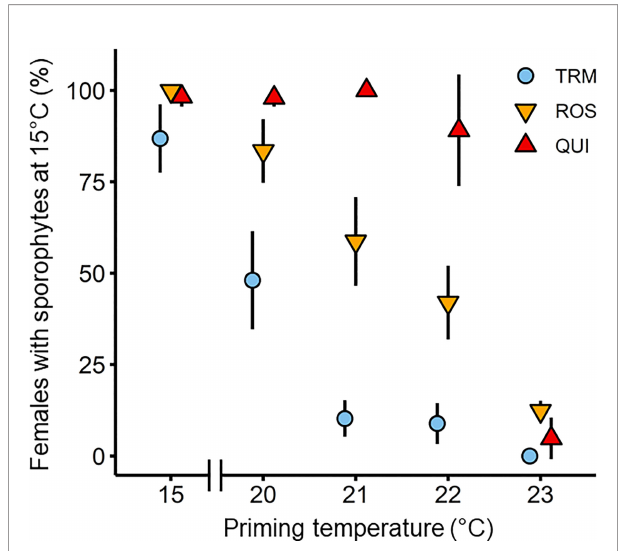
FIGURE 4 | Formation of microscopic sporophytes of Laminaria digitata on day 28, after 14 days of thermal priming at (sub)-lethal non-fertilizing temperatures (20°C, 21°C, 22°C and 23°C) followed by 14 days of recovery at 15°C in the three populations Tromsø (TRM; n = 4), Roscoff (ROS; n = 3) and Quiberon (QUI; n = 4) in experiment 1. 15°C served as control temperature over 28 days. The 24°C treatment was excluded, as only 0%-